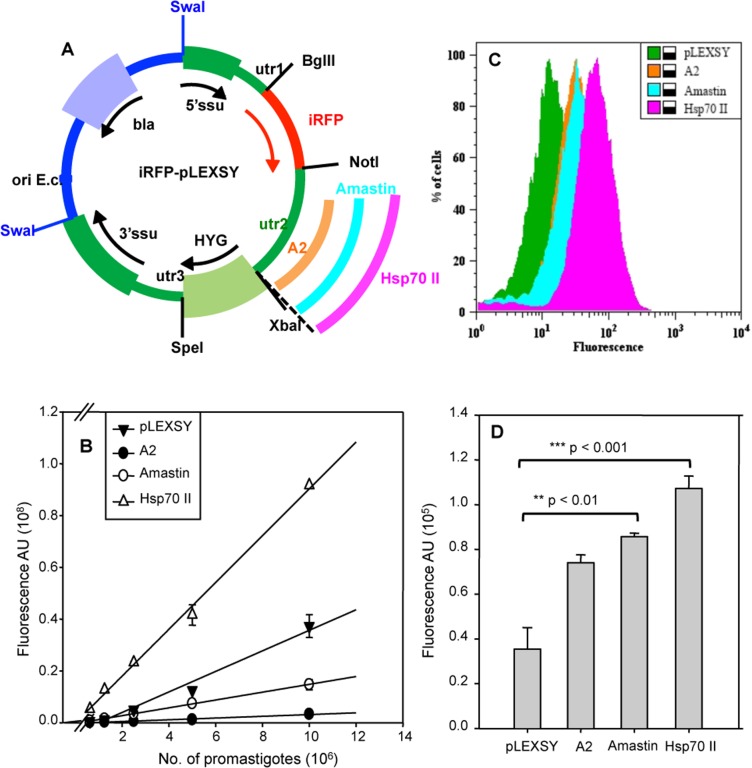
Optimization of pLEXSY-iRFP vector by introducing downstream regions (DSR) of different genes.A) Schematic view of pLEXSY-hyg2 constructs containing infrared (iRFP) reporter gene and different DSR corresponding to A2, AMASTIN and HSP70-II genes. Constructs were linearized by SwaI digestion prior to electroporation. B) Correlation between fluorescence signal and the number of logarithmic promastigotes modified with iRFP-pLEXSY-HYG (□) or carrying the DSR of A2 (●), AMASTIN (○) or HSP70-II (Δ) genes. C) Flow-cytometry analysis of intracellular amastigotes isolated from THP-1 in vitro infections. D) Mean fluorescence intensity emitted by lesion-derived amastigotes obtained from WT and the engineered parasite strains carrying iRFP. Experiments were carried out with 107 parasites by triplicate and error bars represent standard deviations (SD). Significance level *** p< 0,001; ** p<0.01; from two tails of Student t-test.